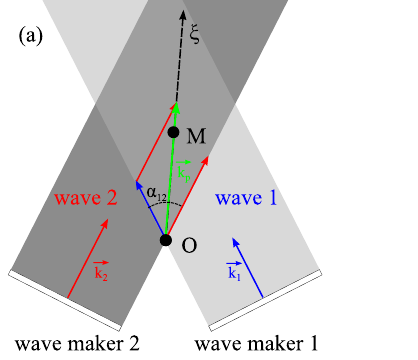
Figure 9. ( a ) Schematic view of the interaction zone between the two mother waves 1 and 2. O is the origin of this zone and M locates a point in this area along the direction O ξ , given by k p = k 1 + k 2 . The two mother waves cross with an angle α 12 . A wave 3 is created in the interaction zone by the quadratic nonlinear interactions between the waves 1 and 2. ( b ) Picture of the experimental setup to characterize three-wave interactions of capillary–gravity waves. The red spot corresponds to the measurement point using the laser vibrometer. A small amount of titanium dioxide has been added to distilled water so that the free surface scatters the laser